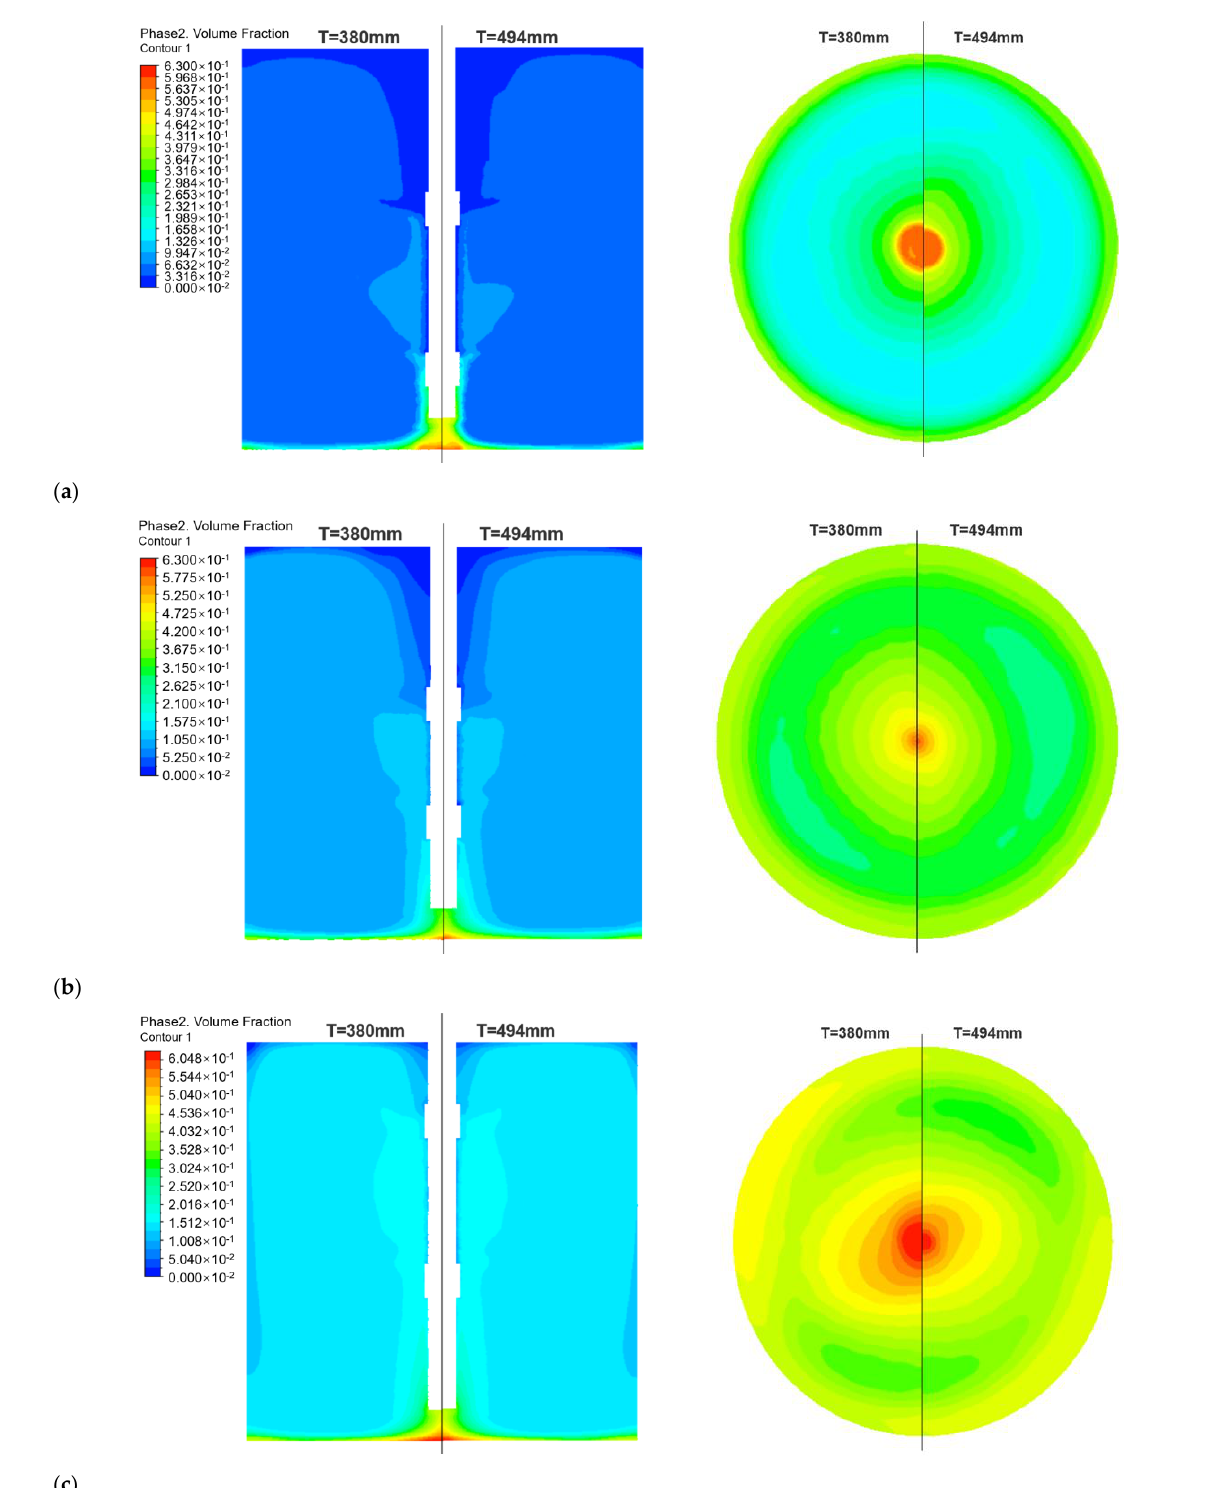
Figure 10. Comparison of solid concentration distributions scaled up based on the same unit volume power: ( a ) Co = 5% v/v ; ( b ) Co = 10% v/v ; ( c ) Co = 15% v/v .